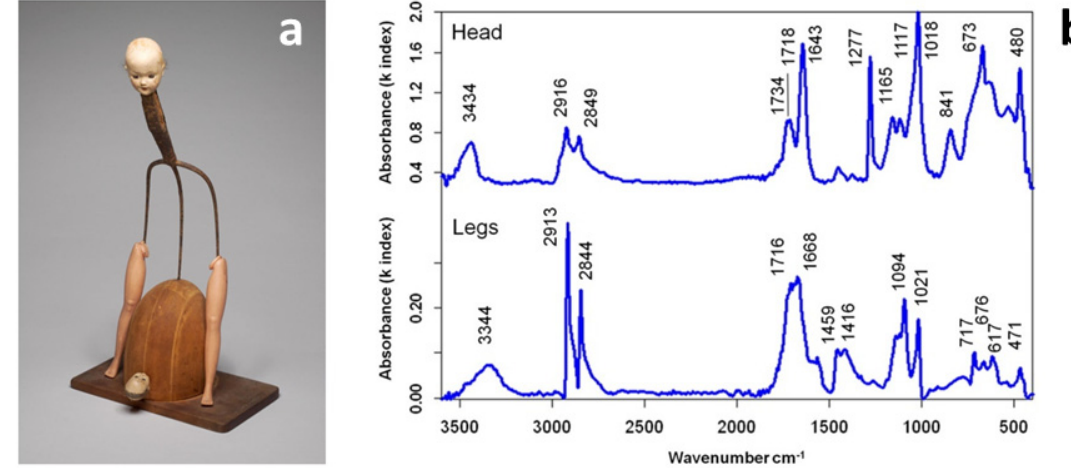
Figure 1 . “Pitchfork Lady” (1964) by Don Baum ( a ) and corresponding Kramers–Kronig transformation (KKT) calculated FTIR spectra for the head and the legs ( b ). Image reprinted with permission from [41].